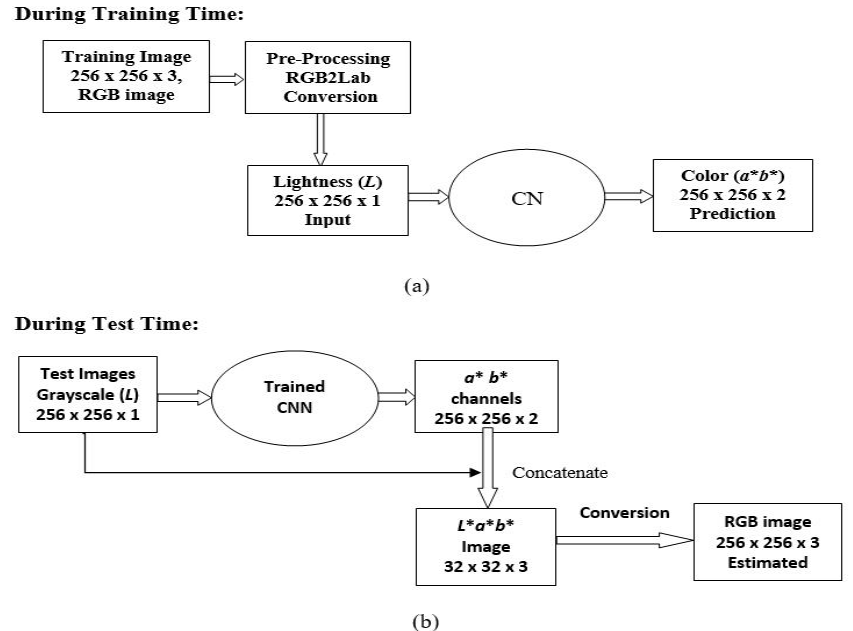
Figure 3. System Flow Diagram for Auto-colorization Model; ( a ) during training and ( b ) during testing.